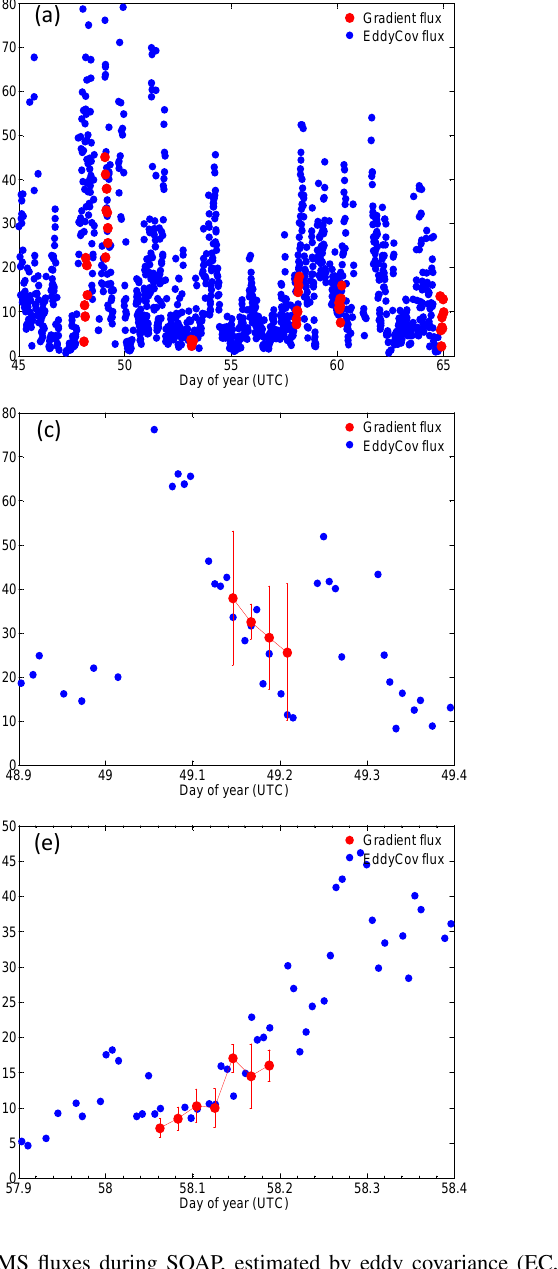
of K depend only on measured fluxes. K was also normal- ized to a Schmidt number of 660 (CO 2 at 25 ◦ C) to facili- tate comparison with other experimental results. The 10 min EC values of K (Bell et al., 2015) were again averaged over the same time intervals as the GF values. K values are of- ten presented as an average over several days or within wind speed bins, due to the inherent or instrumental variability;